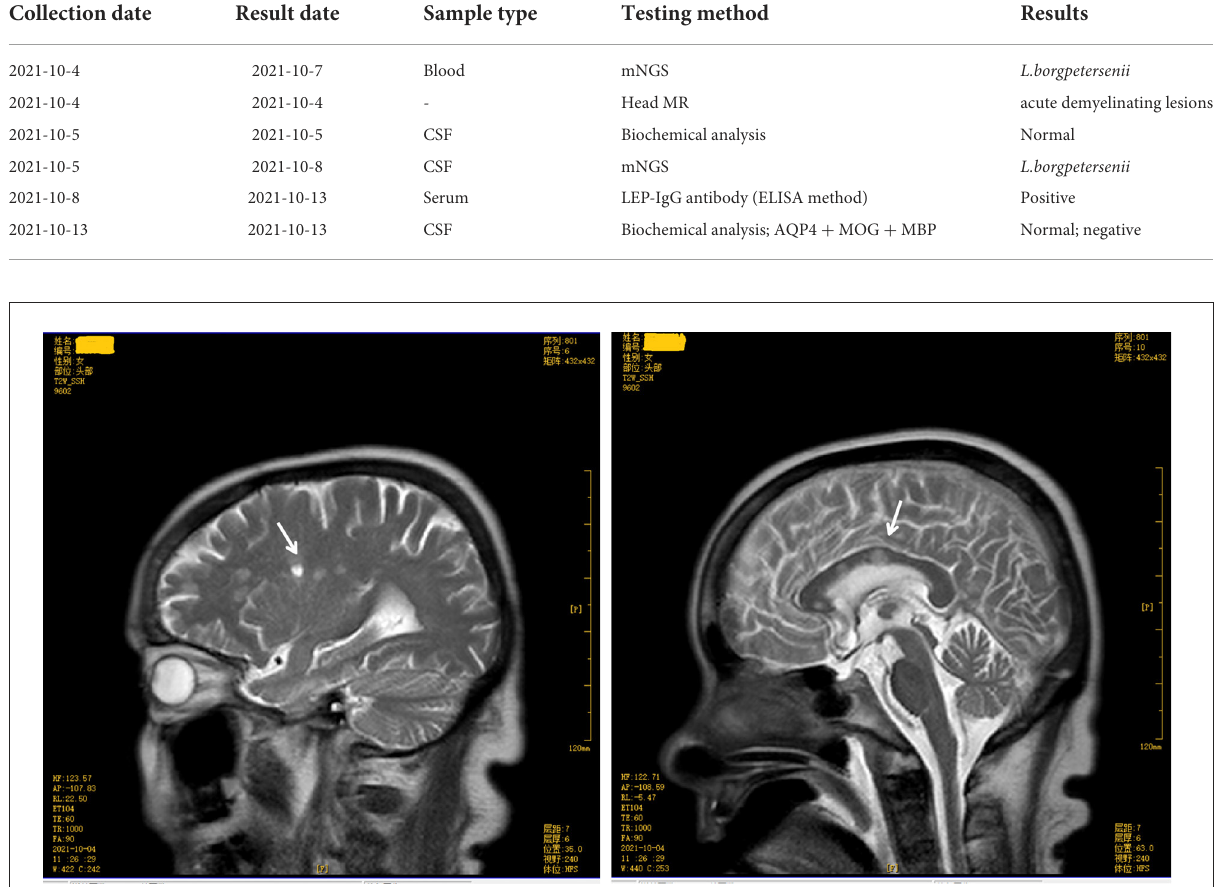
TABLE 3 Details of the confirmatory diagnostic testing for L. borgpetersenii .